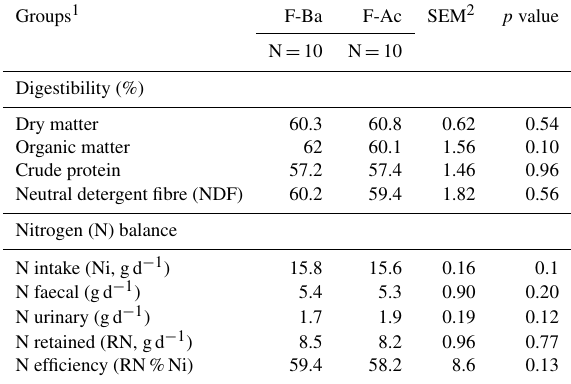
Table 2. Digestibility of diet components (%) and nitrogen (N) bal- ance (gd − 1 ) Groups 1